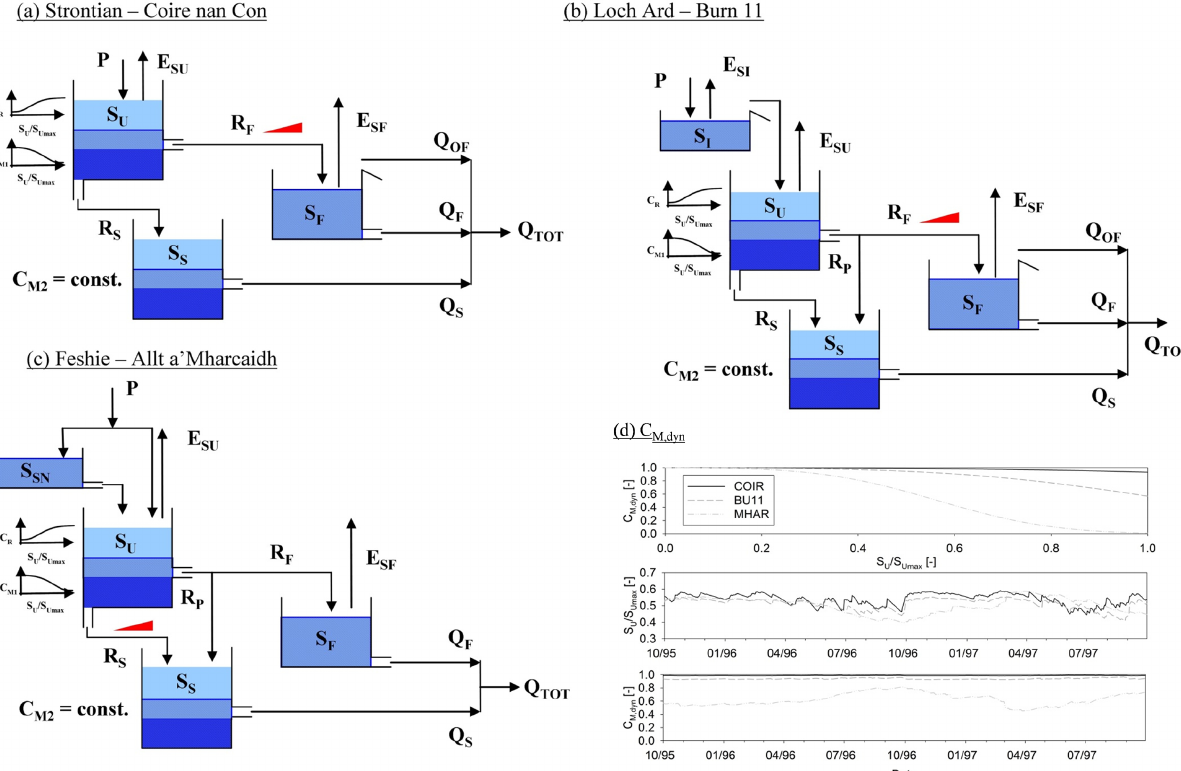
Fig. 3. Selected model structures for the three study catchments (a–c) . Light blue shades indicate volumes not affected by mixing, medium blue shades indicate the fraction of the active volume subject to mixing and the dark blue shades indicate the passive mixing storage. The red triangles indicate the presence of a lag function in the specified parts of the models. The panels in (d) show the dynamic mixing coefficient | µ C M,SU = f (S U /S U CM,SU , σ CM,SU ), the temporal dynamics of S U /S U max as well as of C M,SU for a selected 2-yr period for the three max study